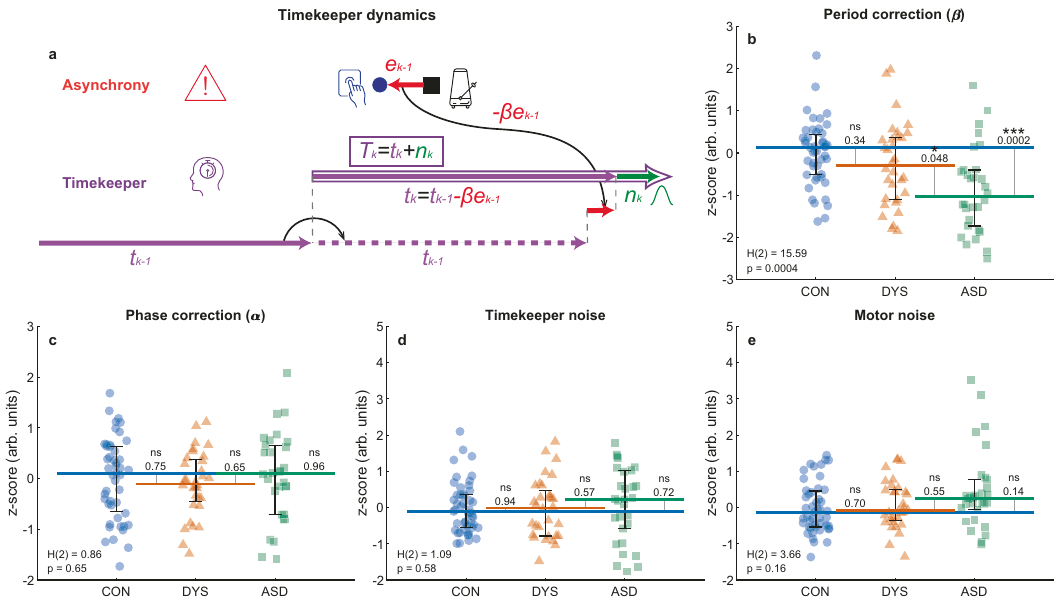
Fig. 6 Trial-by-trial computational modeling of tapping with changing tempos: Parameters estimated for each participant show that individuals with ASD have reduced period correction when the period changes abruptly. a Illustration of the dynamics added to the isochronous computational model (Fig. 3a), which enables tracking of changing tempos 42 . The internal period estimate ( t k , purple) is adjusted in each trial based on the recent asynchrony (in red, the magnitude of the correction is determined by the period correction parameter β ). To produce the tapping interval, noise is added to this estimate ( n k , green) as in the isochronous model. b – e : Each dot represents the combined value from all conditions of tempo-switches per participant (50 – 90 ms; after z -scoring). CON control (neurotypical), DYS dyslexia, ASD autism. N = 109 subjects ( N CON = 47, N DYS = 32, N ASD = 30). b Period correction ( β ) is smaller in the autism group compared with the two other groups, c while phase correction ( α ) is similar in this Experiment. d Timekeeper noise and e Motor noise estimates do not differ between the groups. The median of each group is denoted as a line of the same color; error bars around this median denote an interquartile range. Kruskal – Wallis H -statistic and corresponding p value are in the bottom-left corner; p values of comparisons between groups are next to the line connecting the groups ’ medians. Source data are provided as a Source Data fi le.